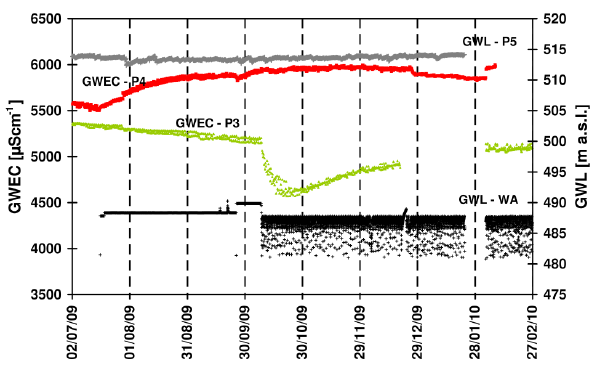
Fig. 4. Continuous groundwater electrical conductivity (GW EC ) monitoring for piezometers P3 and P4 and groundwater level (GW L ) monitoring in WA and P5.